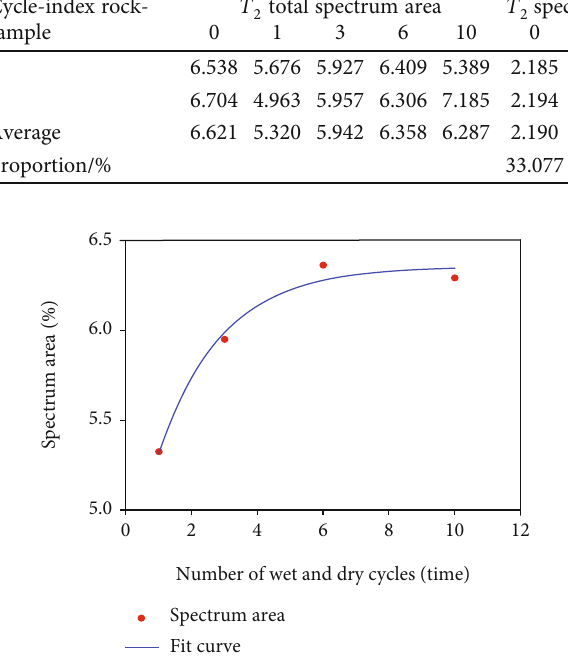
Figure 5: Fitting curve of relationship between the area of T spectrum and the number of dry and wet cycles.